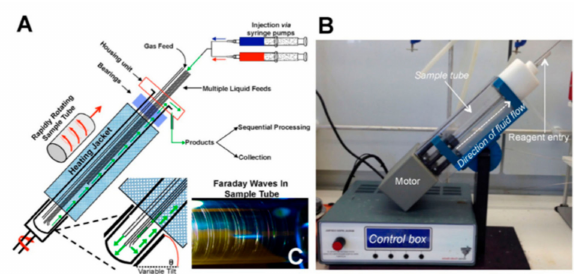
Figure 4. Representations of the vortex fluidic device. ( A ) A schematic of the vortex fluidic device; ( B ) A photograph of the vortex fluidic device; (reproduced with permission from [30]).